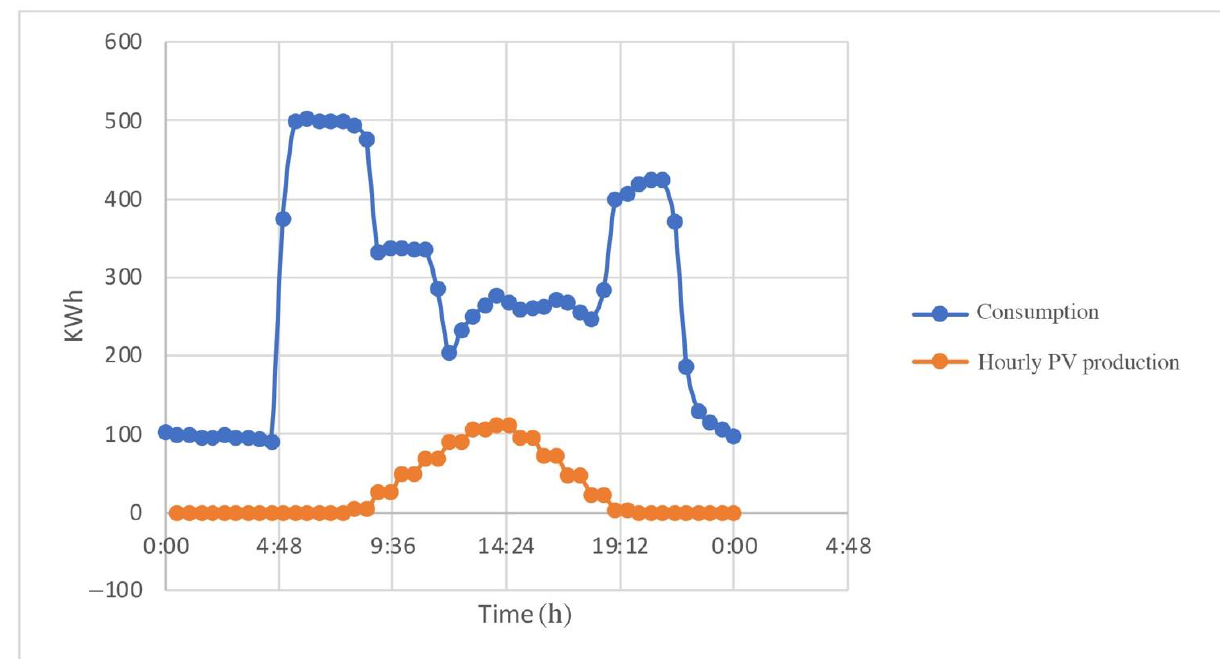
Figure 7. One-day energy consumption and PV production.